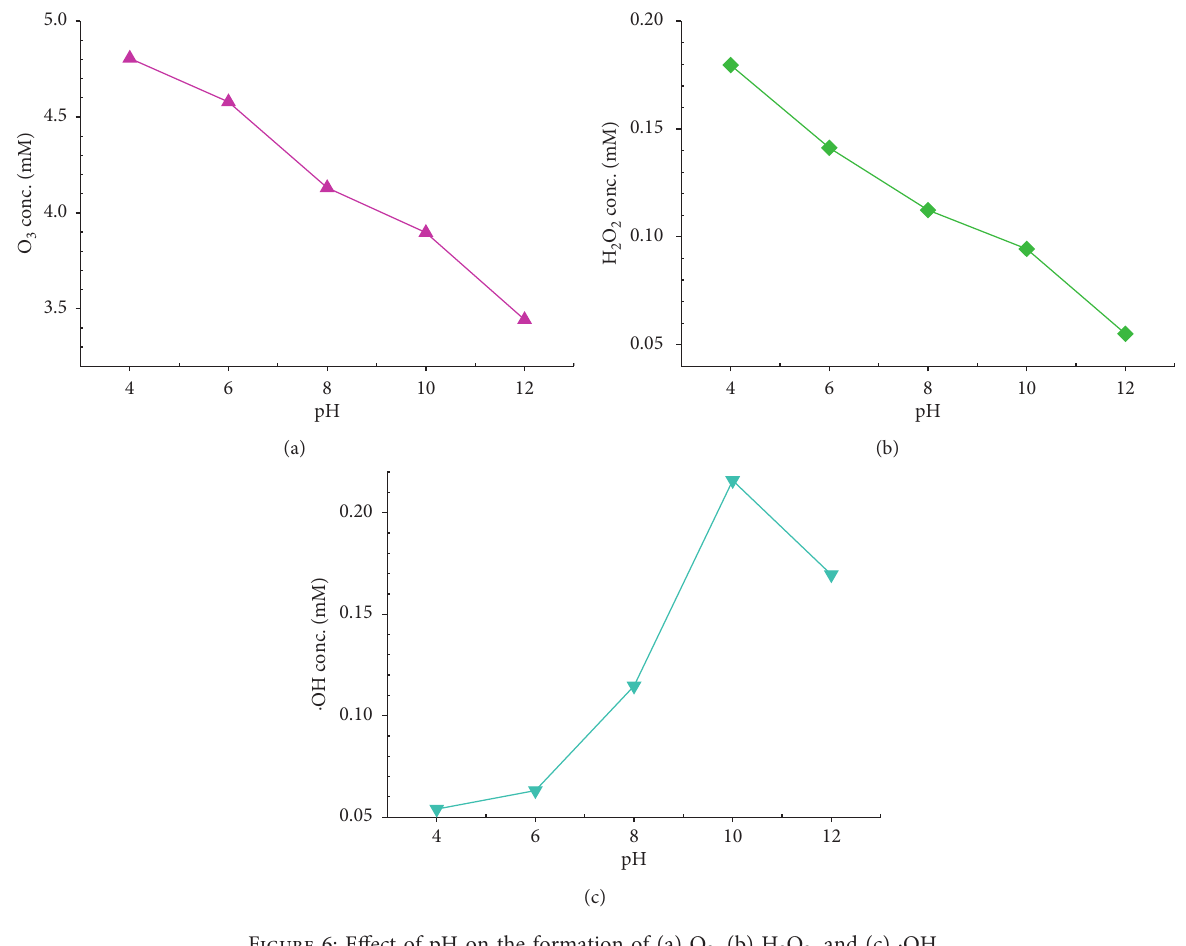
· OH. 3 , (b) H 2 O 2 , and (c)